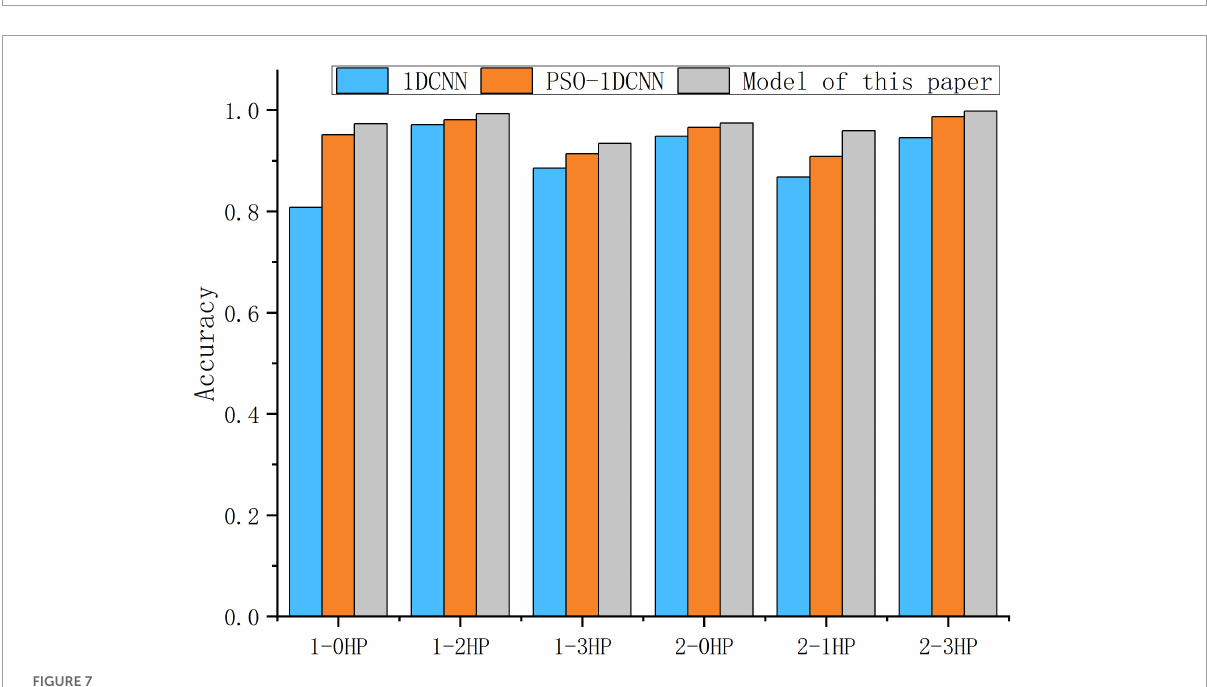
FIGURE7 The accuracy of each model under variable working conditions.